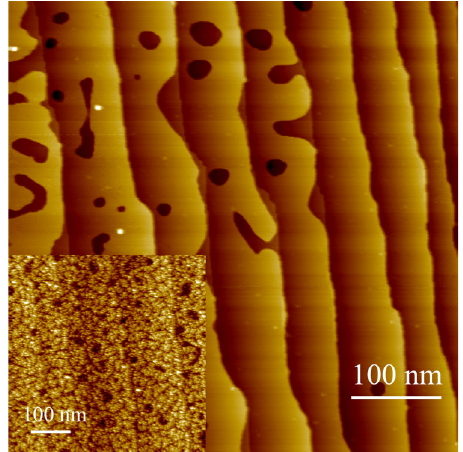
FIG. 1. A typical STM image of 4-ML Pb film ( 500 nm × 500 nm, sample bias 2.0 V, tunneling current 500 pA). Inset: STM image of Si capping layer on 4-ML Pb film ( 500 nm × 500 nm, sample bias 3.0 V, tunneling current 500